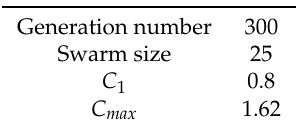
Figure 16. Close-up to the contact area between two bodies analyzed with proposed IGA-BEM before optimization. Table 8. Data to run the PSO algorithm.